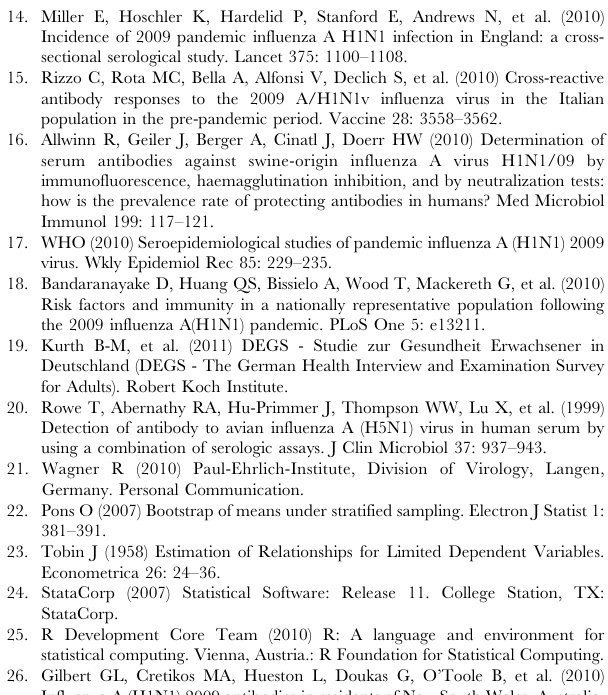
Table S5 GMT by three birth cohorts in pre- and